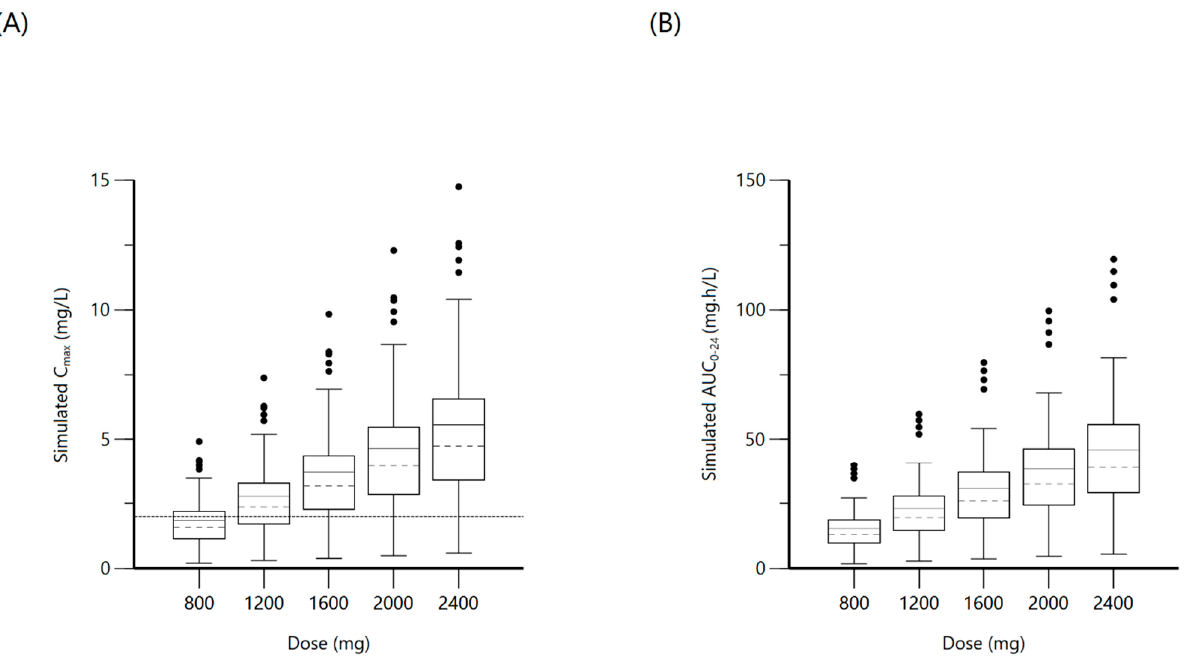
Figure 8. Plot ( A ) represents simulated ethambutol C max at various doses with the dashed line indicating the minimum threshold of 2 mg/L. Plot ( B ) represents simulated ethambutol AUC 0-24 at various doses.